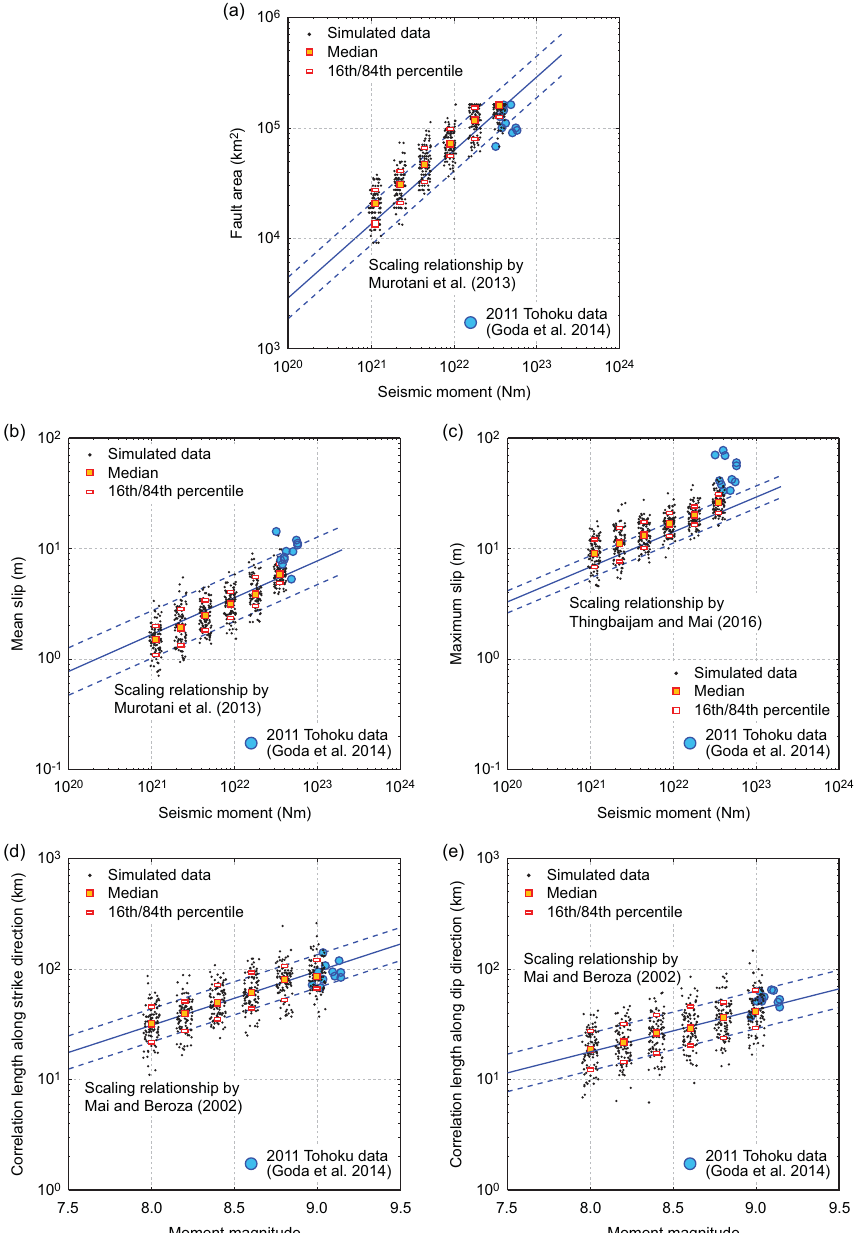
Figure 3. Scaling relationships and simulated parameters in stochastic scenario generation: (a) seismic moment – fault area, (b) seismic moment – mean slip, (c) seismic moment – maximum slip, (d) moment magnitude – correlation length along strike direction, and (e) moment magnitude – correlation length along dip